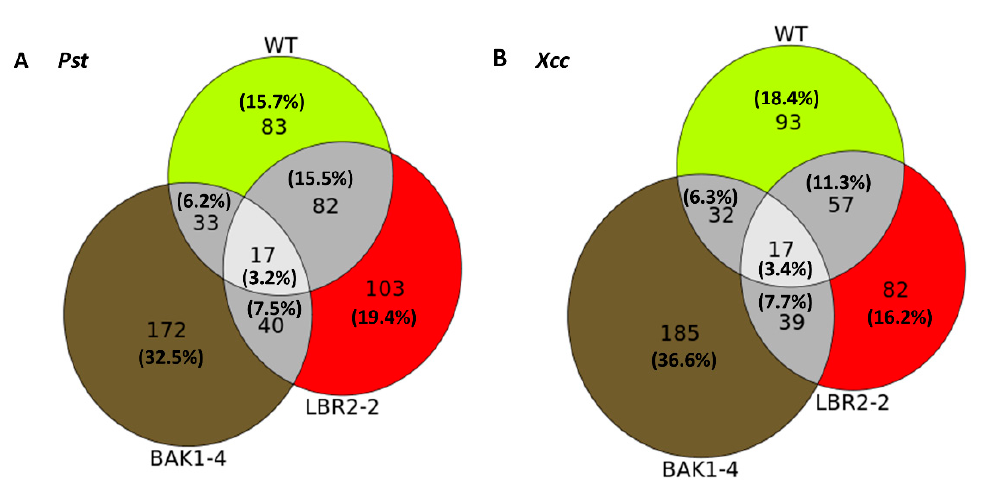
Figure 1. Venn diagram representations of how the groups of PM-associated proteins in the WT, lbr2-2 and bak1-4 plants relate to one another after treatment with LPS from Pst ( A ) and Xcc ( B ). The numbers in the sectors indicate the unique/distinct and overlapping/shared/common proteins.